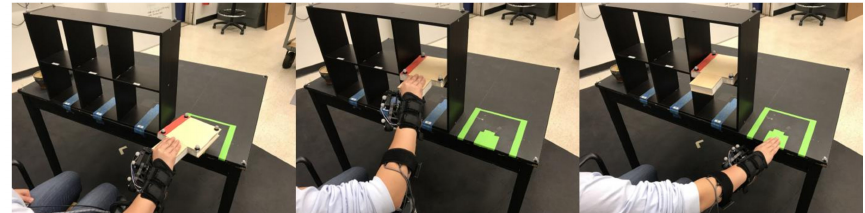
Figure 2. Grasping action taken by subjects. For each motion, the subject grasps the book from the starting position on the table ( left ), places the book onto a cubby ( middle ) and the taps the marked spot on the table ( right ) before reversing the series of actions and placing the book back onto the starting position. For each grasp, the thumb is on the bottom supporting the book so that thumb closure is required for the